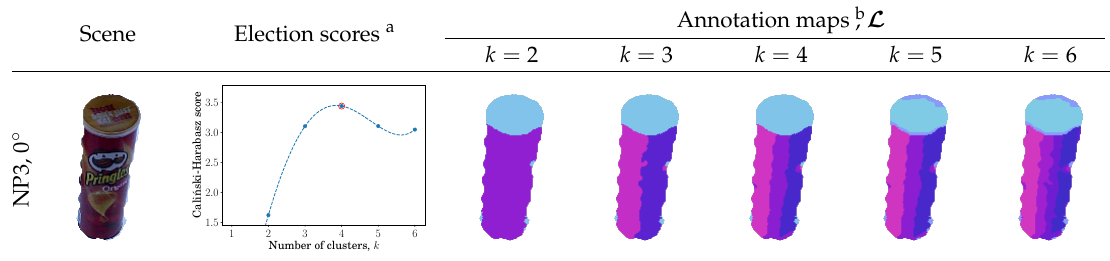
Figure 14. Sample qualitative cases of correspondences and 6D pose estimation using local image features, for the standalone and embedded (3D Affine) methods, under a wide viewpoint change. The alignment error, (cid:96) ( ψ 60 ◦ ) , is visualized over the 3D model of the source image. ≈